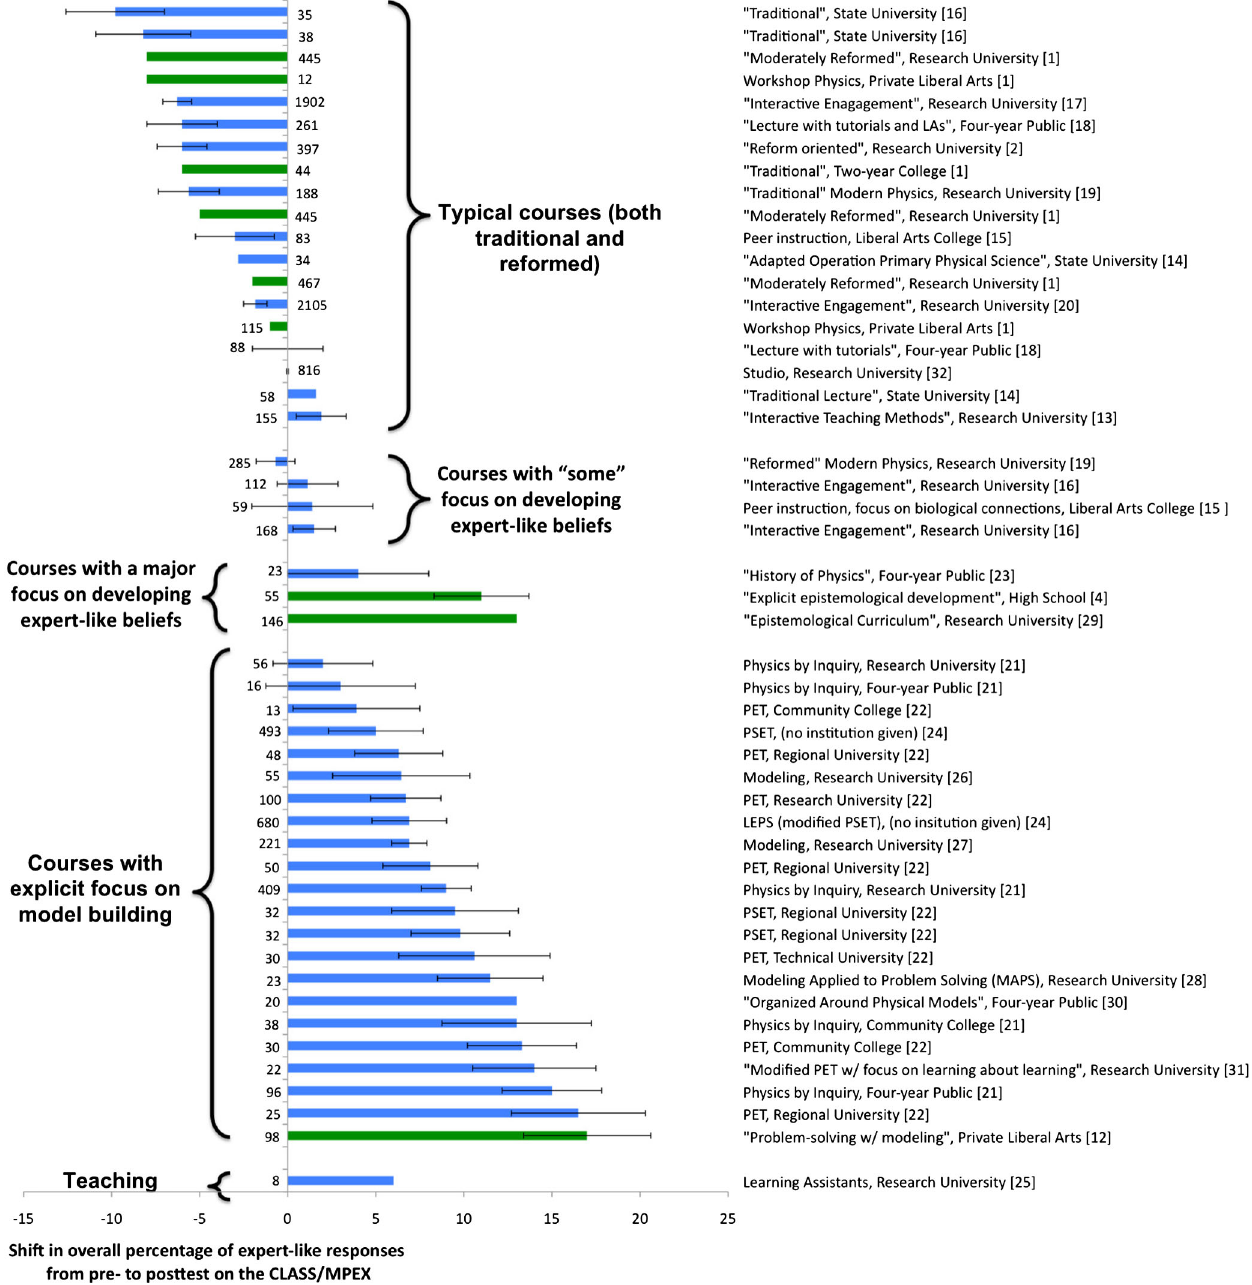
FIG. 2. Shifts in percent expertlike on CLASS or MPEX by teaching method. Courses taught with traditional and reformed methods showed varying levels of positive and negative shifts. Courses that paid some attention to developing beliefs had no shift. Those that put a major focus on developing positive beliefs had positive shifts. Courses that explicitly focused on model building also had positive shifts. One small study of learning assistants found that these students also had a positive shift in beliefs. Classification of courses was determined by authors based on description of course provided in paper. PET ¼ Physics of Everyday Thinking curriculum, PSET ¼ Physical Science of Everyday Thinking